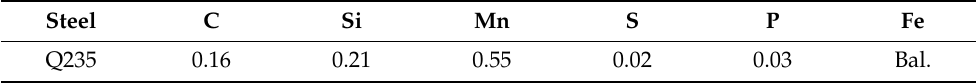
Table 1. Chemical composition of workpiece [Mass fraction/%].